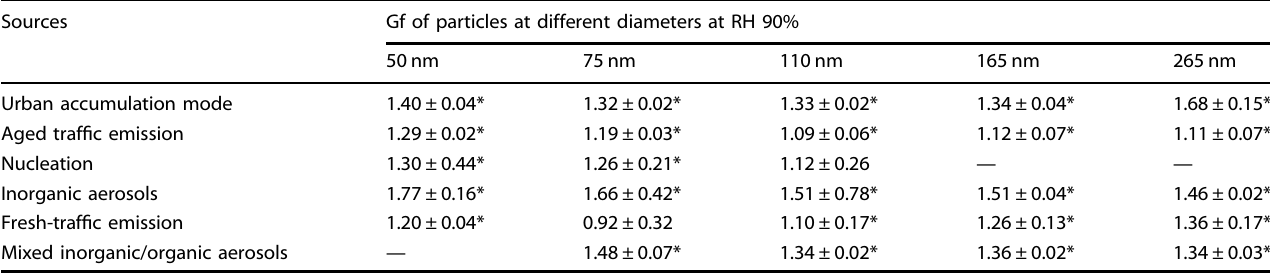
Fig. 3 Time trends in the estimated number fraction. Comparing the measured hydrophobic fraction of particles at 110 nm (red) with the PMF factor contribution of traf fi c aerosols (blue). Table 1. Hygroscopic growth factors of particles from different sources (from both summer and winter